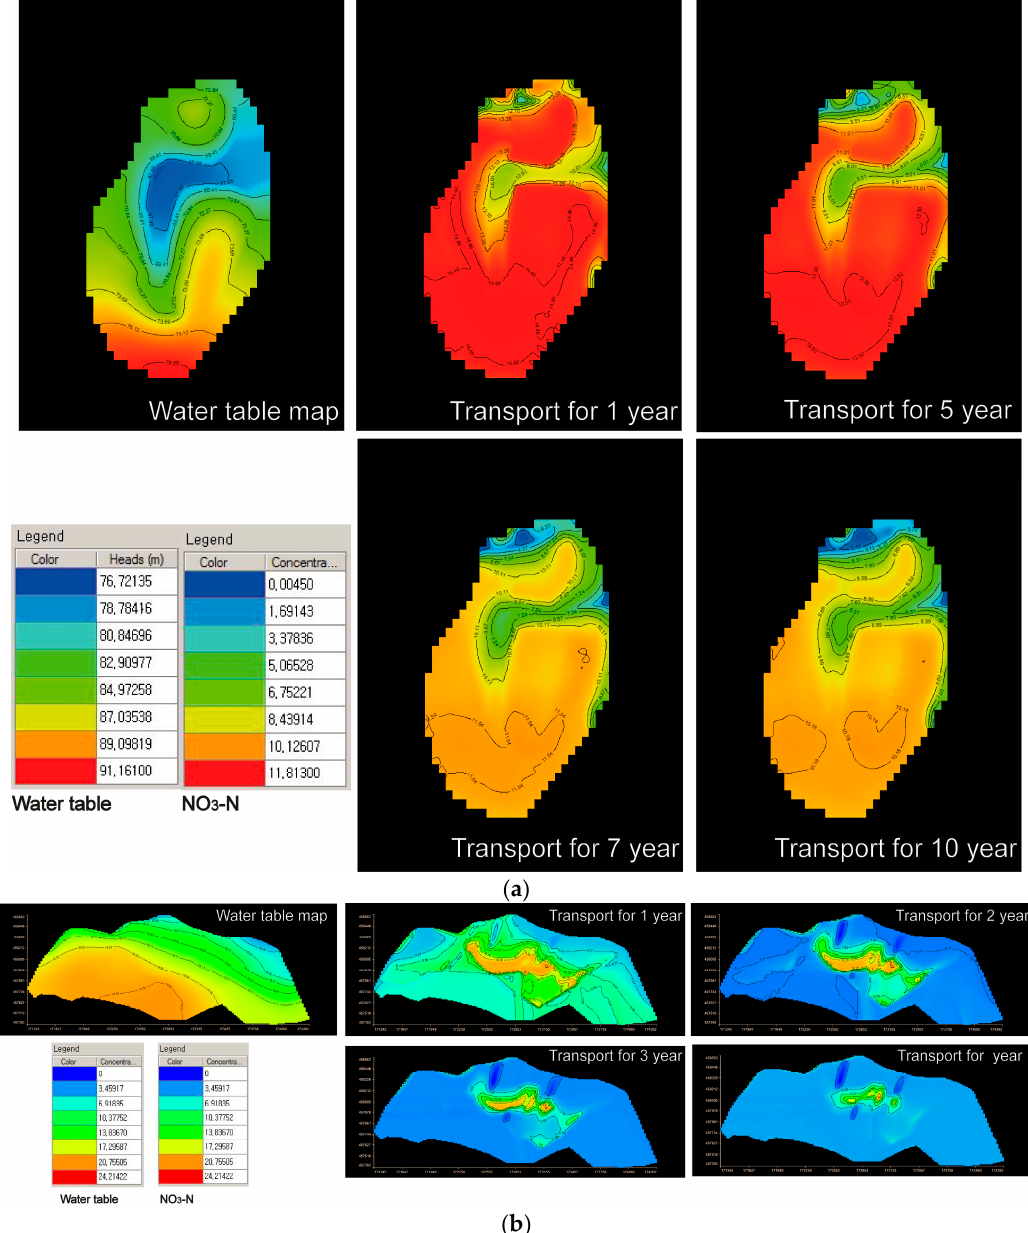
Figure 5. Results of the NO 3 -N transport modeling in ( a ) 2015 and ( b ) 2016.